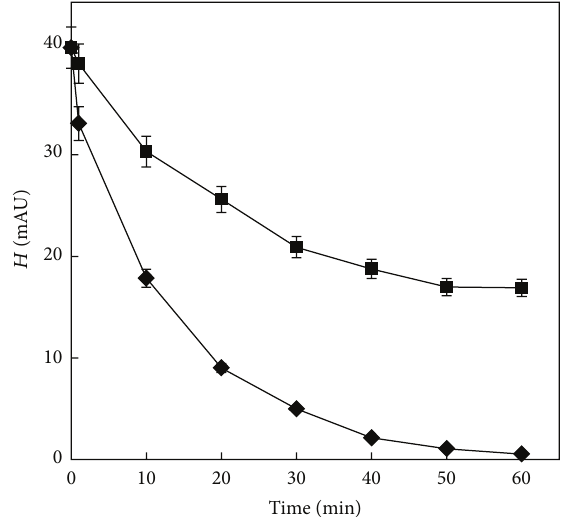
Figure 9: Changes of the chromatographic peaks heights (degrada- tion) of B[a]P with time, ( ⧫ ) pH 2.7, ( ◼ ) pH